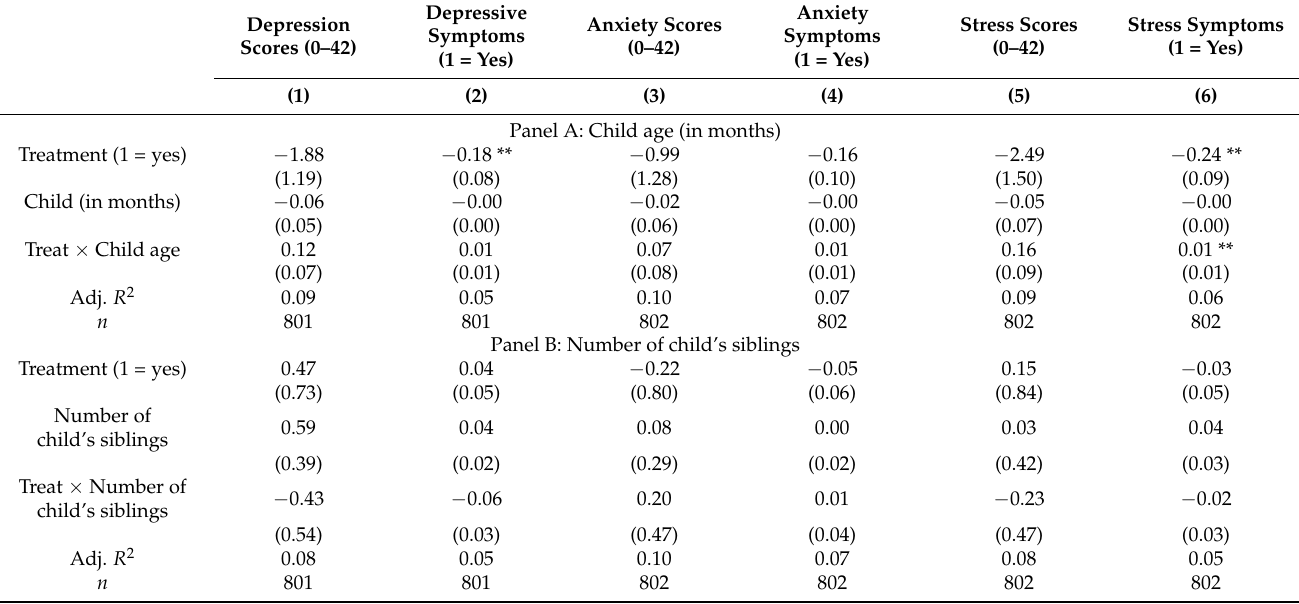
Table 6. Heterogeneous effects of the intervention on the mental health of the female